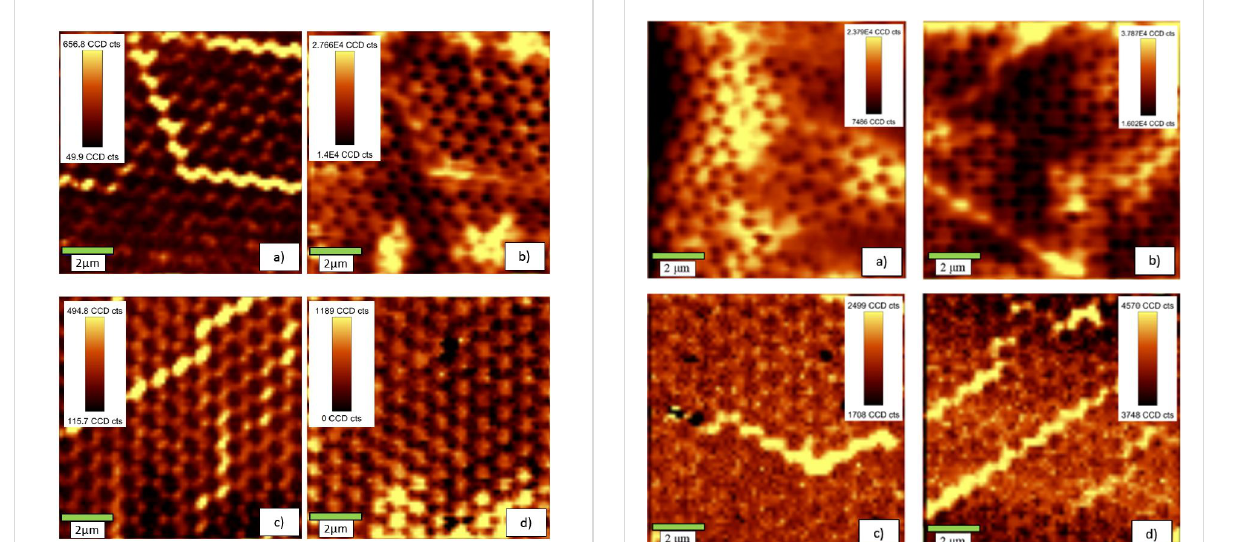
layer thickness, which might be associated with local variations of the wetting behavior caused by the Ag nanoantennas.